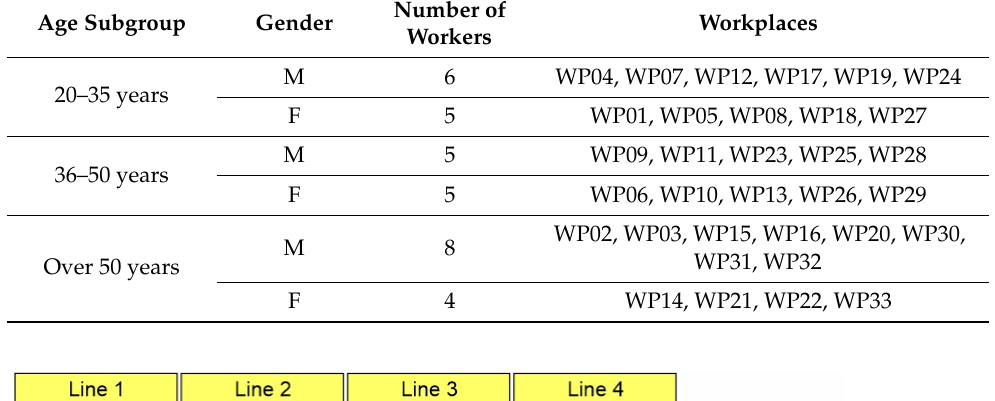
Table 3. Analysed workplaces.